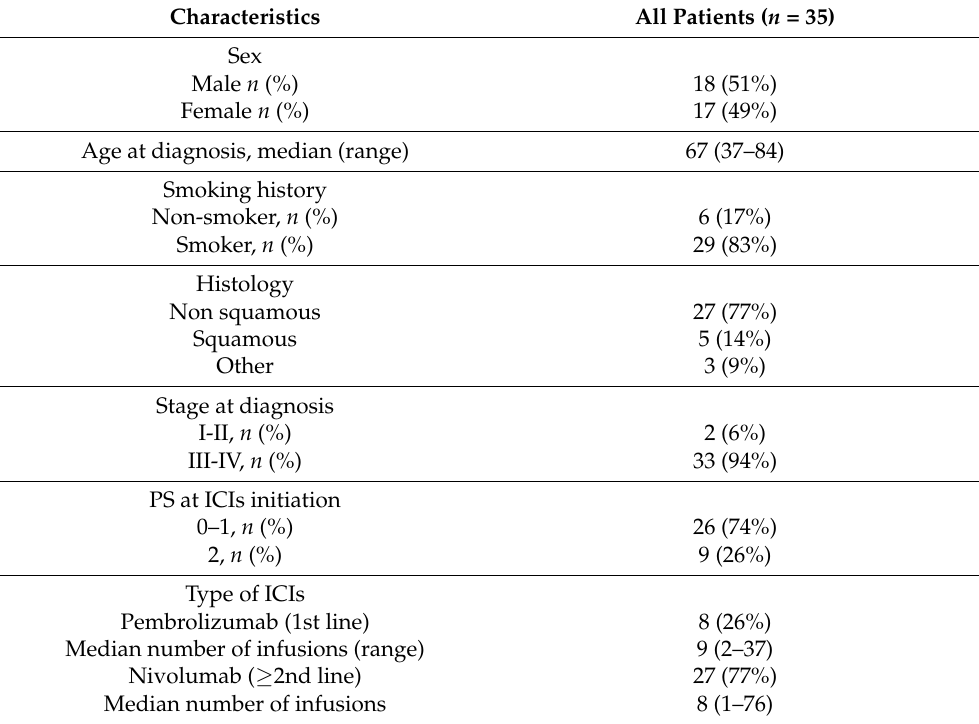
Table 1. Patients’